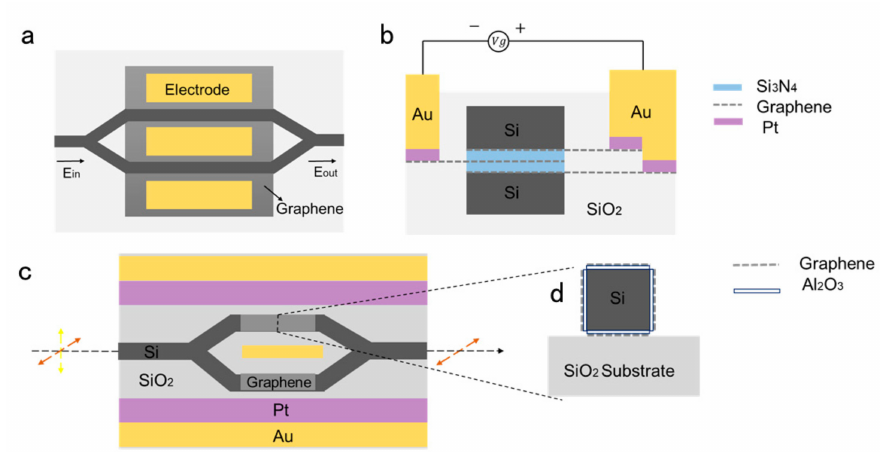
Figure 9. ( a ) Two-dimensional (2D) vertical view of the modulator and ( b ) 2D cross section of the modulator’s arm. One metal electrode is brought into contact with the first and third graphene layers. Another metal electrode is brought into contact with the second graphene layer. n Si = 3.47, n SiO2 = 1.447, n Si3N4 = 1.98. ( c ) The three-dimensional (3D) view of the proposed polarizer; ( d ) the schematic view of the proposed